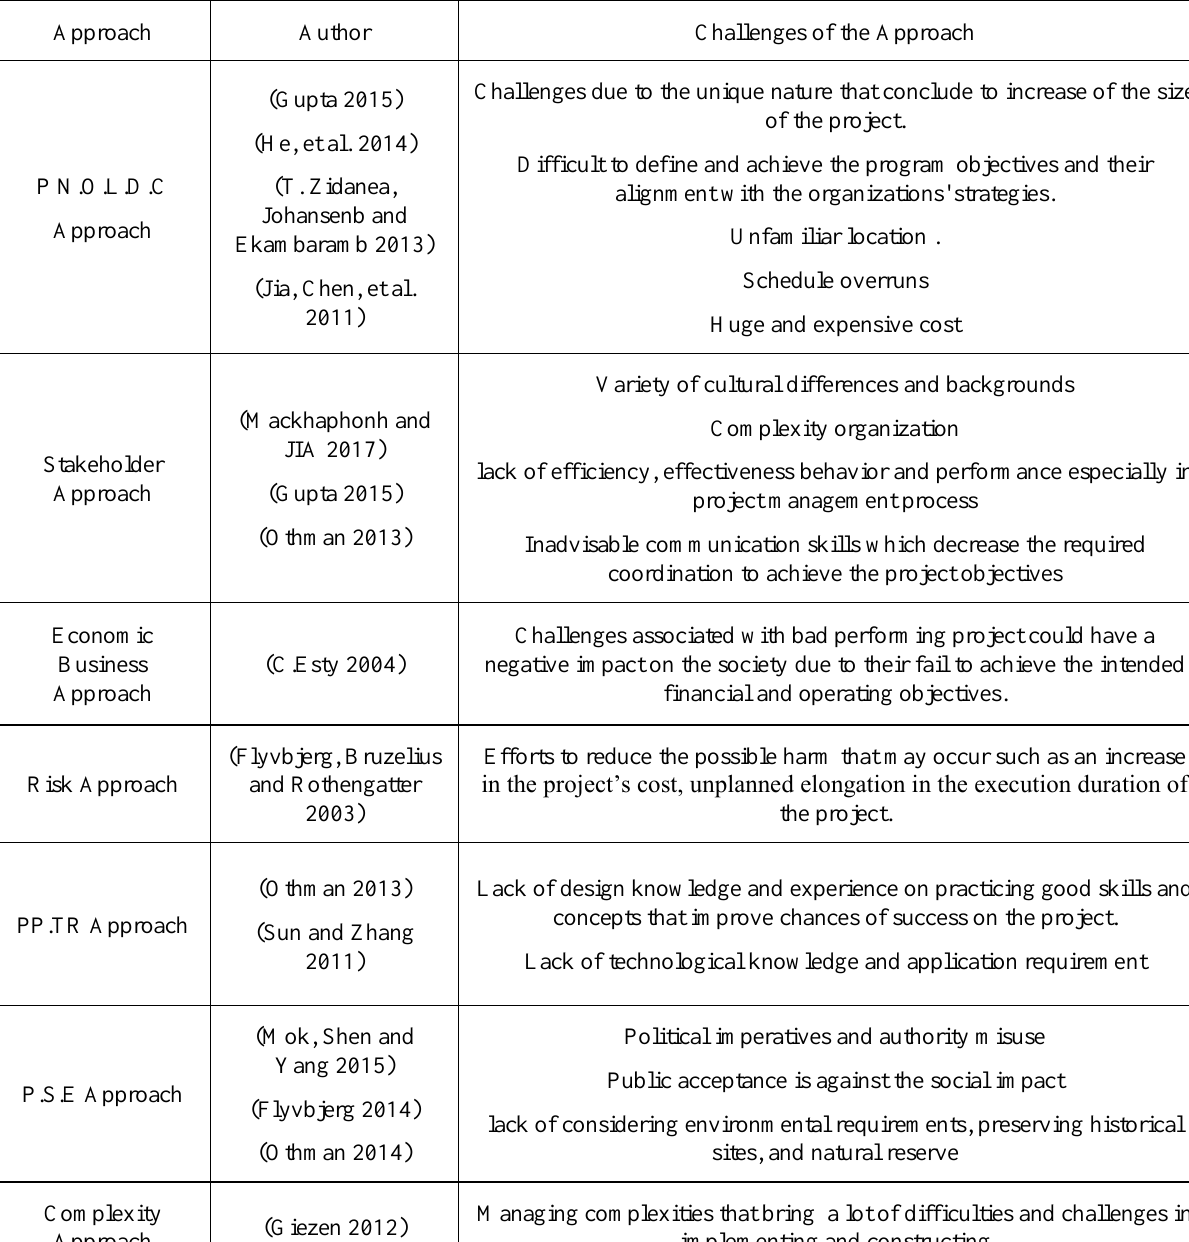
Table 3.Challenges of Mega construction Projects with respect to different approaches “Source: Authors based on literature sources”